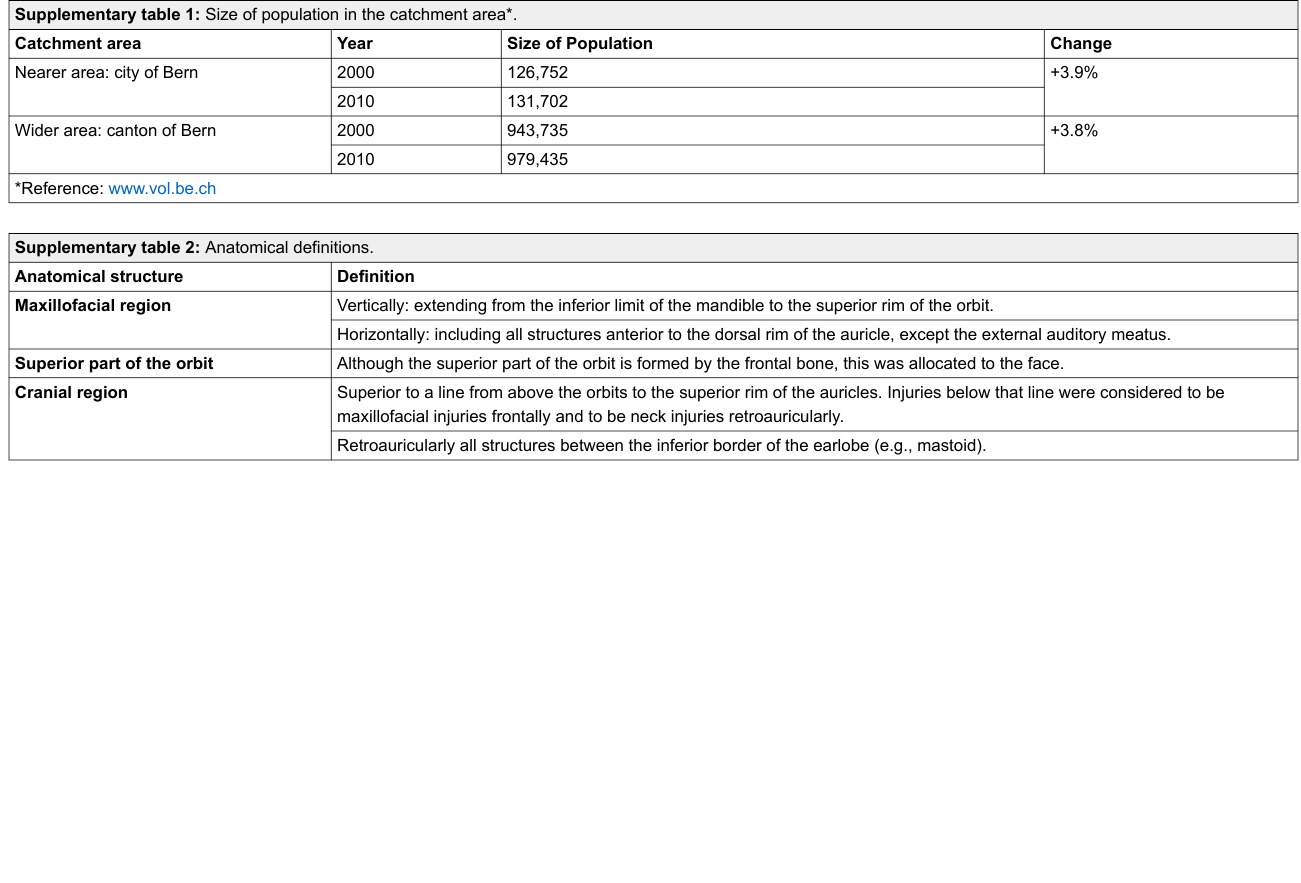
Supplementary table 1: Size of population in the catchment area*.